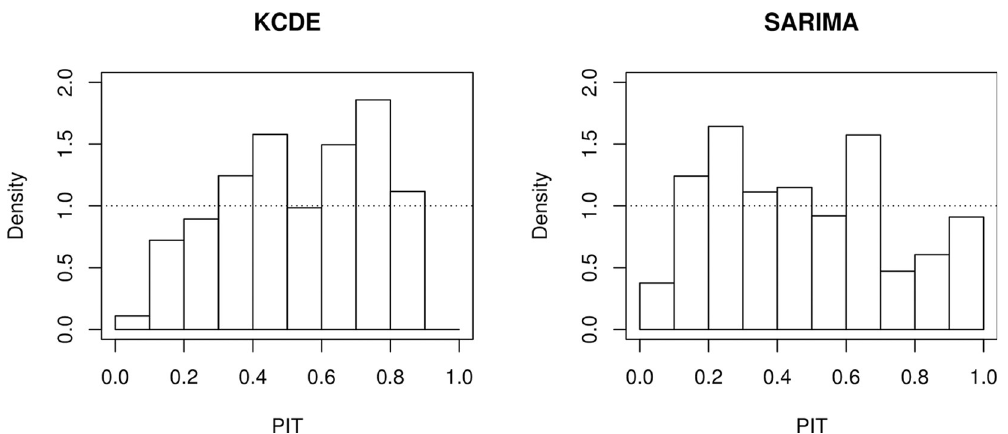
Fig 5. PIT histograms. PIT histograms for 1-week-ahead forecasts from the KCDE and SARIMA models, 2016–2017 FluSight season. Note that to account for the discreteness of the binned distribution, we employed the nonrandomized correction suggested in [13].